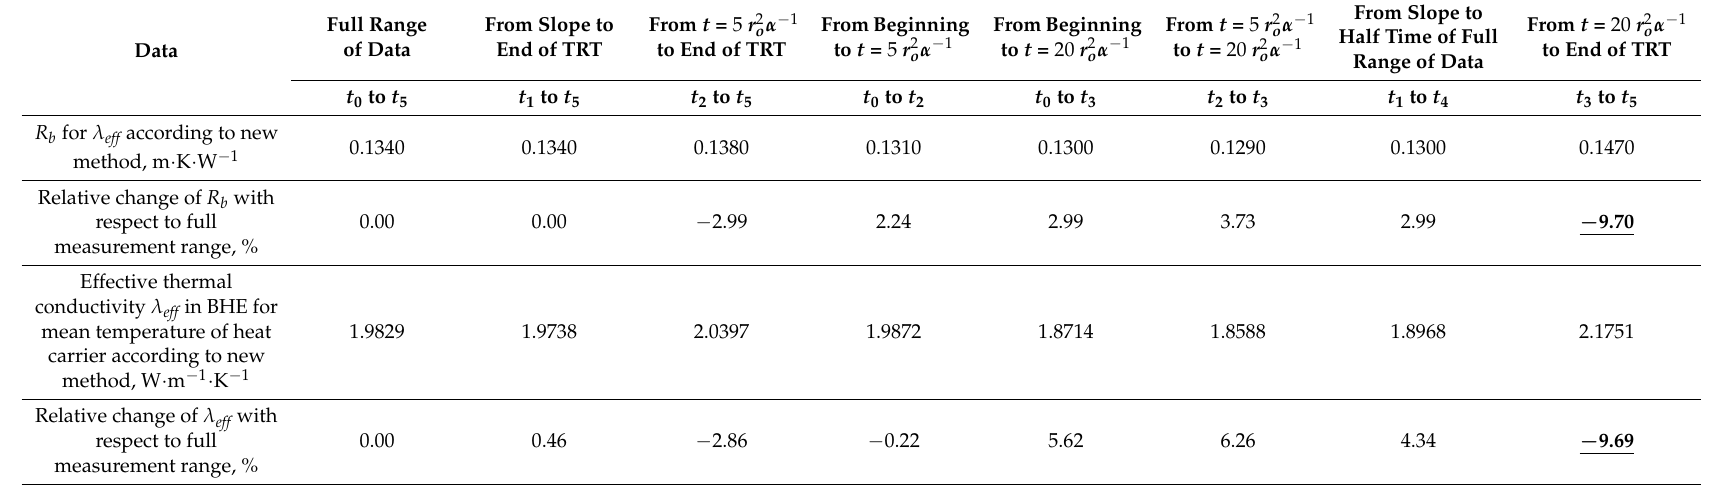
Table 7. BHE thermal resistivity R b and effective thermal conductivity λ eff , determined using the new method for various data intervals (for TRT at Laboratory of